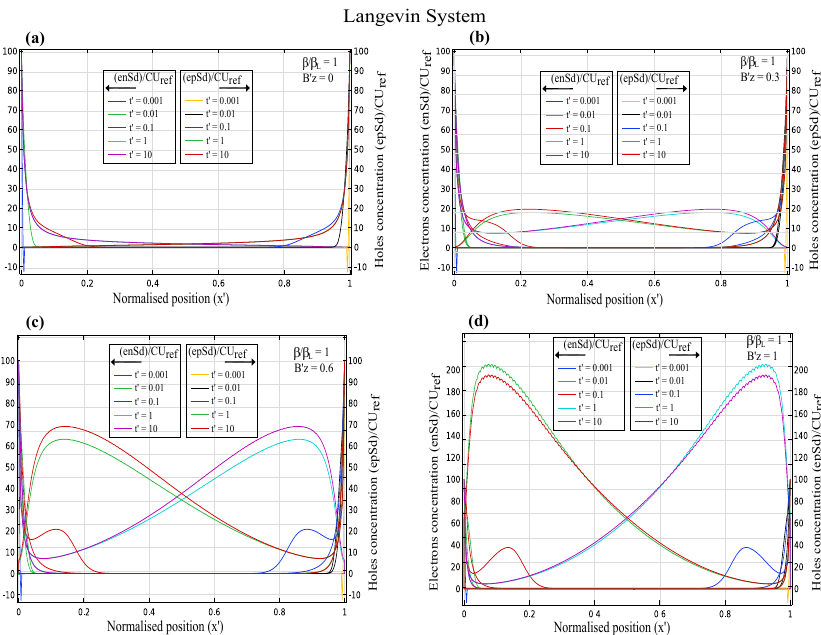
Figure 1. Time-dependent charge carrier concentration for electrons and holes as a function of normalised position x (cid:48) with varying magnetic fields of ( a ) B (cid:48) = 1 for Langevin system with β ( d ) B (cid:48) z